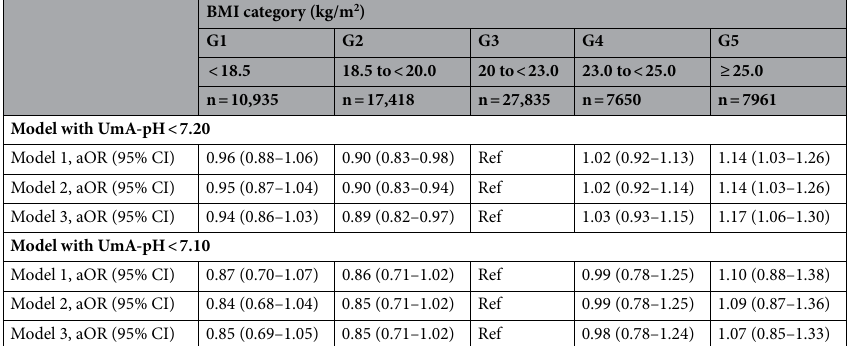
Table 2. aORs and 95% CIs for intrapartum foetal acidosis by pre-pregnancy BMI. Logistic regression models were used to calculate the adjusted odds ratios and 95% CIs for UmA-pH < 7.20 and < 7.10, using G3 as the reference group. aOR, adjusted odds ratio; BMI, body mass index; CI, confidence interval; Ref., reference; UmA-pH, umbilical artery pH. Model 1 was adjusted for maternal age, maternal education, annual household income, maternal smoking during pregnancy, and parity. Model 2 was adjusted for covariates in model 1 and preterm birth and small for gestational age infants. Model 3 was adjusted for covariates in model 2 and mode of